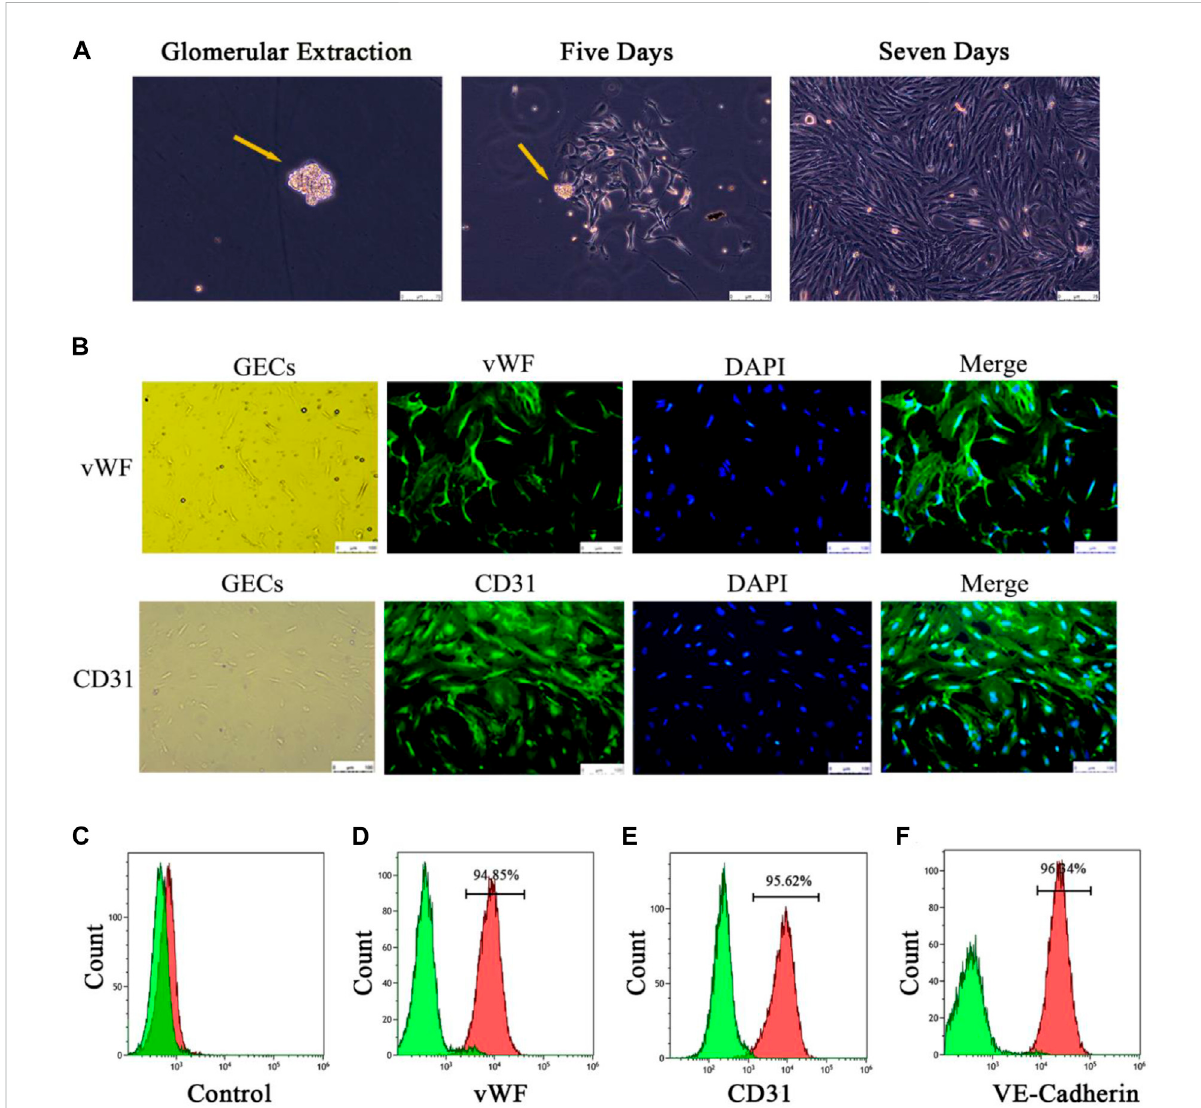
FIGURE 4 Extraction and identi fi cation of primary GECs from each group of mice after Lyme-Exo treatment. (A) Recorded the GECs crawling out of the glomerulus and dynamic growth process using a phase contrast microscope (yellow arrows represent glomeruli, scale bar 75 μ m). (B) Immuno fl uorescence detection of the surface markers CD31 and vWF in GECs (scale bar, 250 μ m). (C) Negative control group. (D – F) Flow cytometric detection of the marker proteins CD31, vWF, and VE-cadherin in